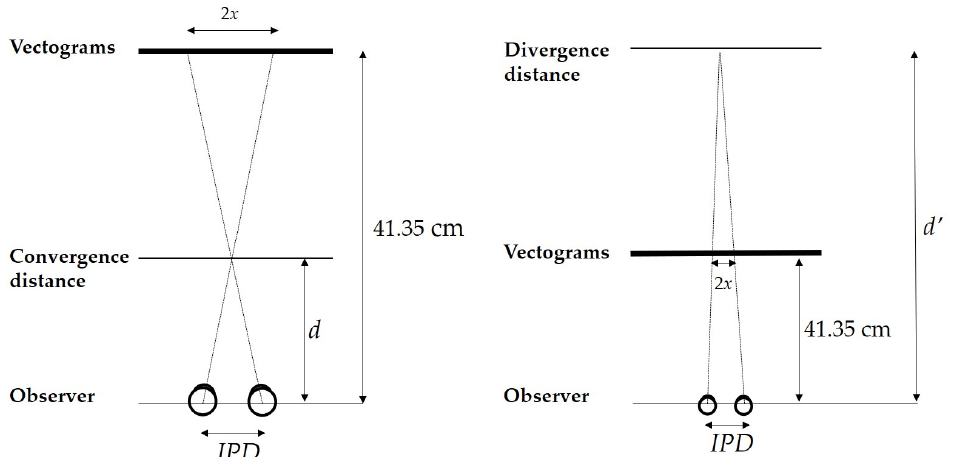
Figure 1. Geometrical calculation of the Small-In, Large-Out (SILO) effect (distance to the perceived stimuli). Similar triangles were defined to determine the theoretical distance in convergence (Small-In) and divergence (Large-Out). IPD = Interpupillary distance; D = Distance from the center of rotation of the eye to the vectogram; d = distance measured in convergence; d’ = distance measured in divergence; x = half the separation distance between the two circular targets (figure not to scale).